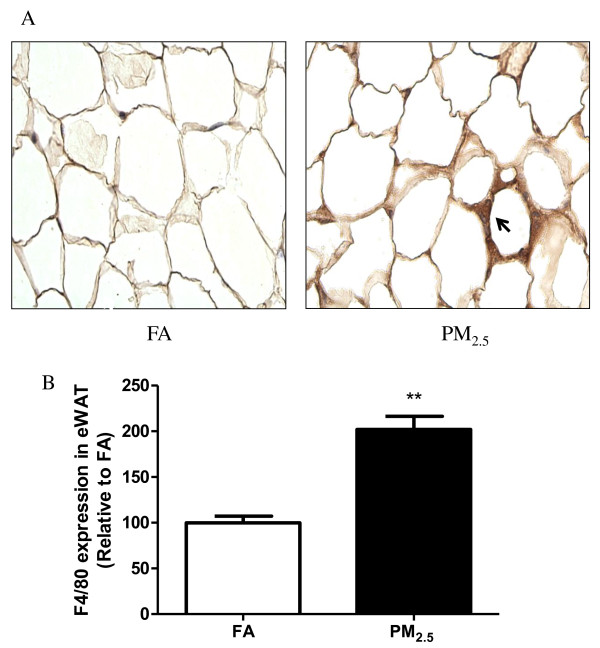
PM2.5 exposure increases macrophage infiltration in the eWAT. A. Immunochemistry for macrophage-specific marker F4/80 in sections of eWAT from FA- and PM2.5-exposed mice. B. Quantification of adipose tissue macrophages in eWAT. n = 4. **P < 0.001 vs. FA. Arrow shows F4/80+ macrophages.